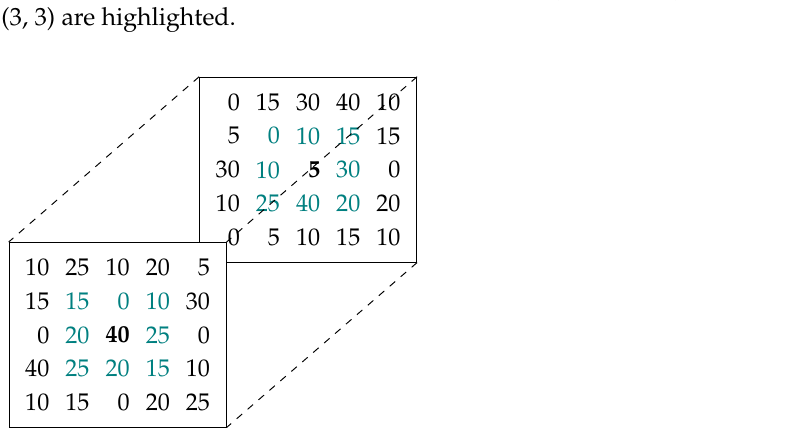
Figure 2. The 3D data grid at time stamp t .